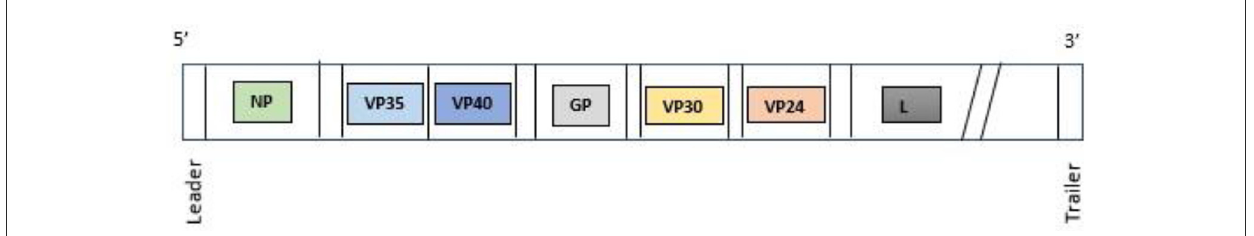
FIGURE1 Ebolavirus genome. NP, nucleoprotein; VP35, Ebola viral protein 35; VP40, Ebola viral protein 40; GP, glycoprotein; VP30, Ebola viral protein 30; VP24, Ebola viral protein 24; L, RNA-dependent RNA